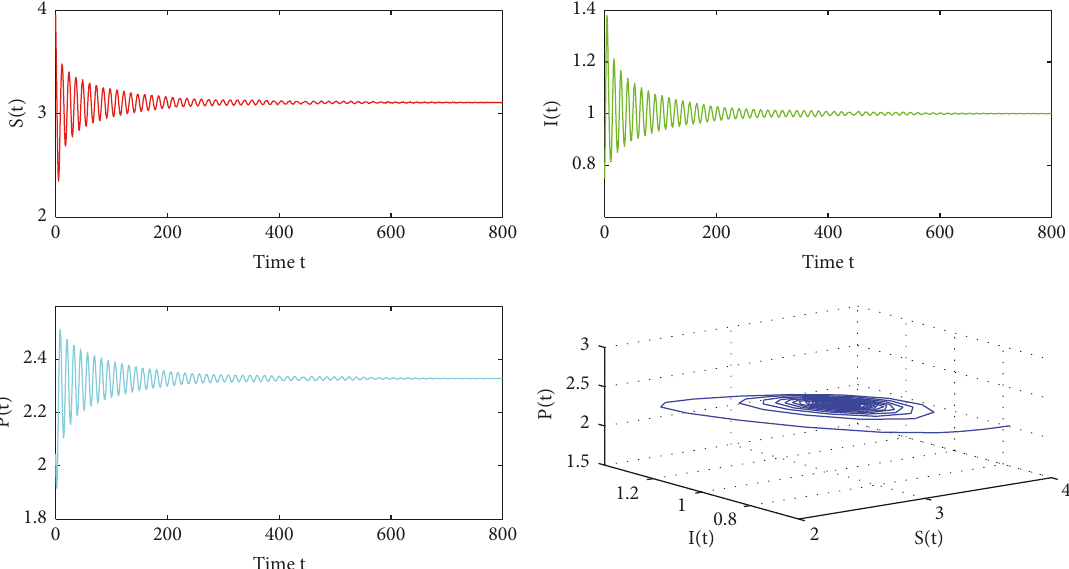
Figure 2: 𝐸 ∗ is locally asymptotically stable when 𝜏 = 0.265 < 𝜏 0 .